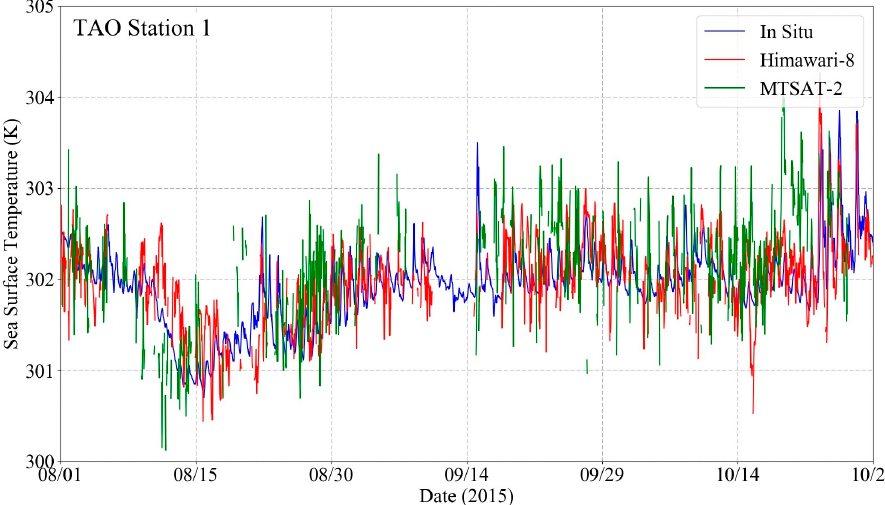
Figure 3. Time series of near-surface temperature measurements at the TAO-1 mooring at 0°N, 147°E (blue) and the satellite-derived SST from Himawari-8 (red) and MTSAT-2 (green).